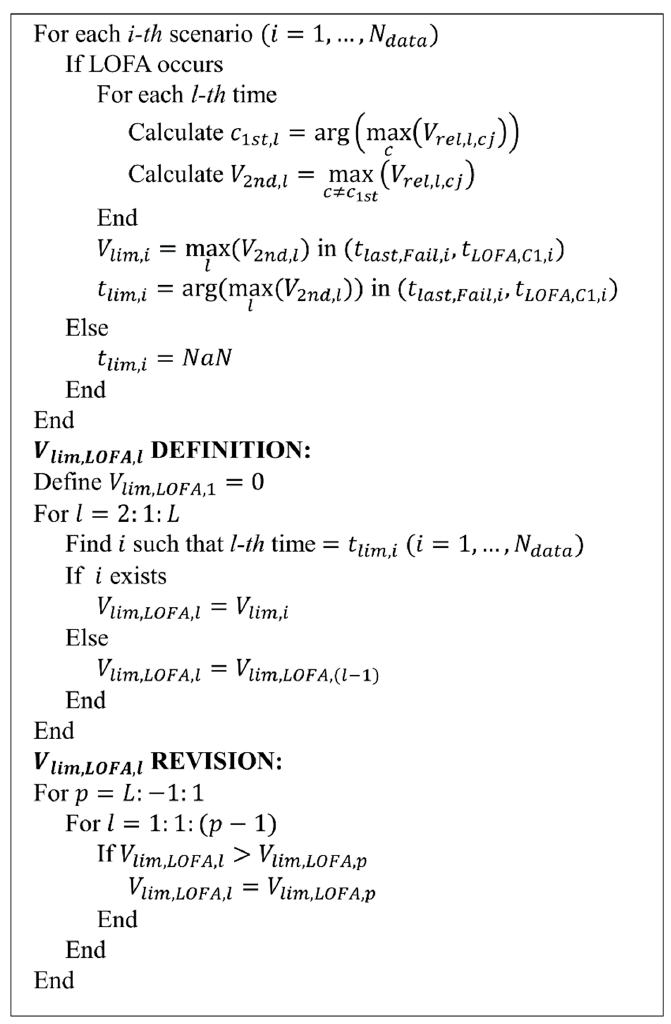
Figure 7. (cid:1848) (cid:3039)(cid:3036)(cid:3040),(cid:3013)(cid:3016)(cid:3007)(cid:3002),(cid:3039) calculation procedure. Figure 7. V lim , LOFA , l calculation In Figure 7, (cid:1872) (cid:3039)(cid:3028)(cid:3046)(cid:3047),(cid:3007)(cid:3028)(cid:3036)(cid:3039),(cid:3036) is the time when the last failure before (cid:1872) (cid:3013)(cid:3016)(cid:3007)(cid:3002),(cid:3004)(cid:2869),(cid:3036) occurs.